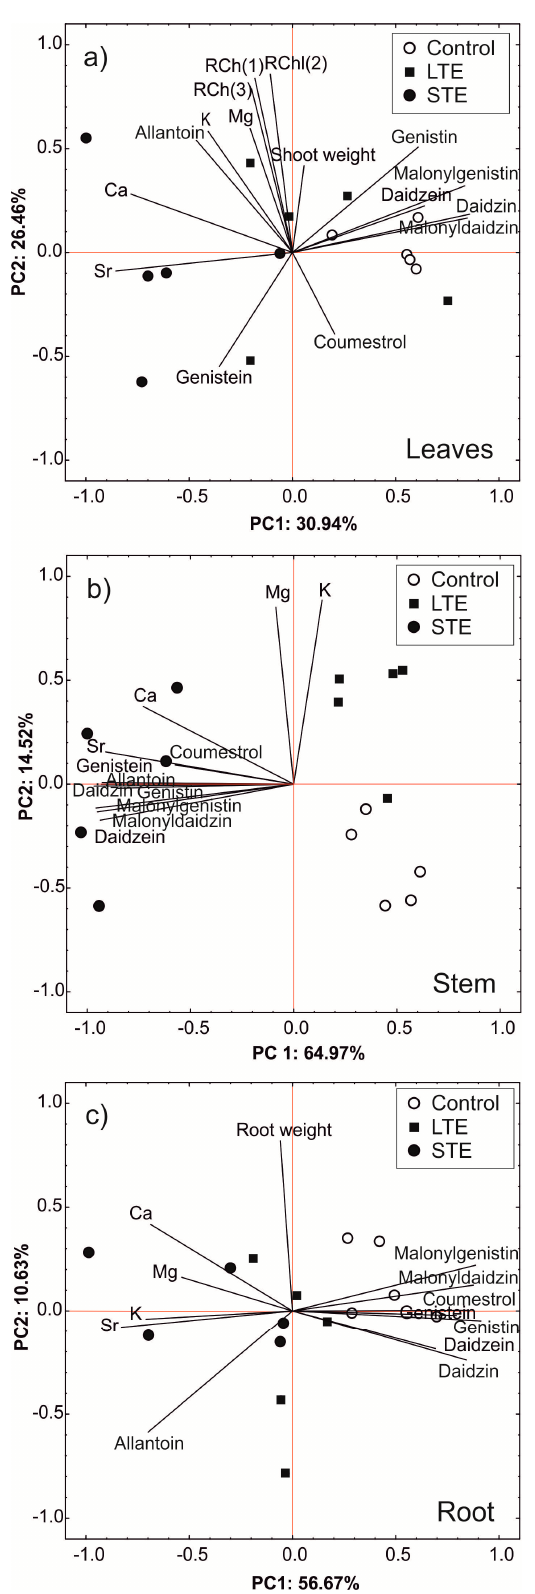
Figure 5. Principal component analysis of Glycine max leaves ( a ), stems ( b ), and roots ( c ) (for each organ, n = 5). Abbreviations: LTE, long-term exposure to Sr; STE, short-term exposure to Sr; RCh, relative chlorophyll content.